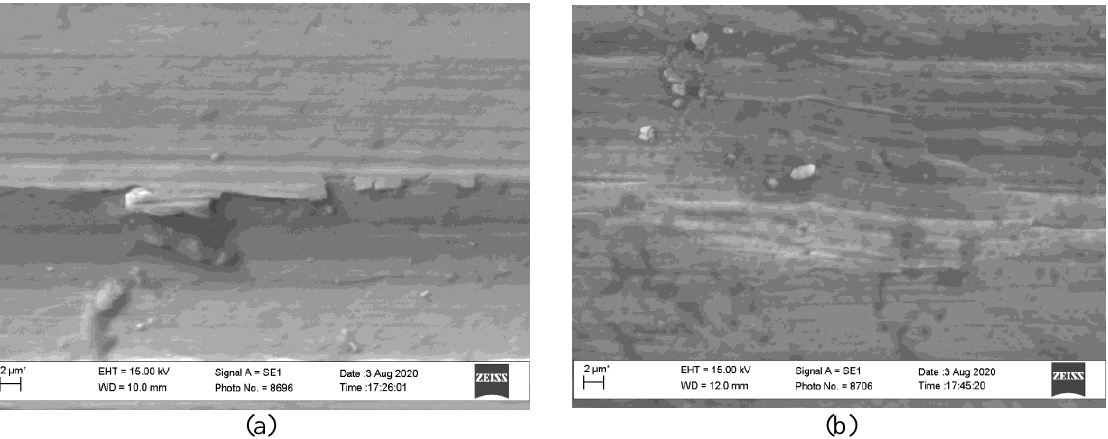
Fig. 4. Worn surfaces of the hardfacings: (a) FCAW-S-140Cr15TiSi1MnVB; (b) FCAW-S-110Cr4Cu5Ti1VB with exothermic